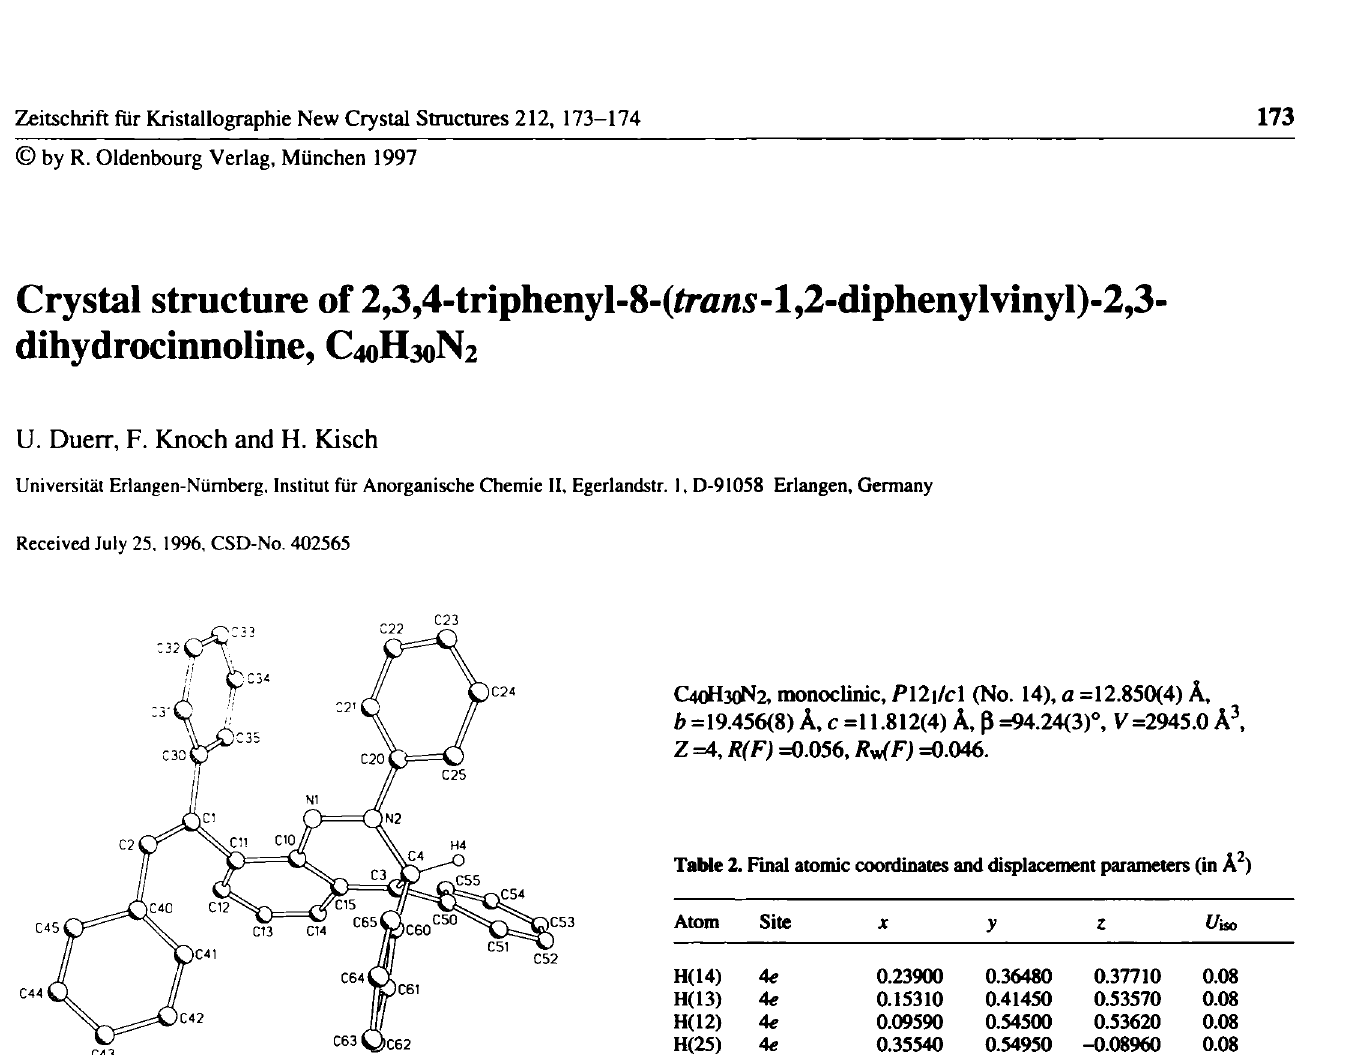
Table 1. Parameters used for the X-ray data collection